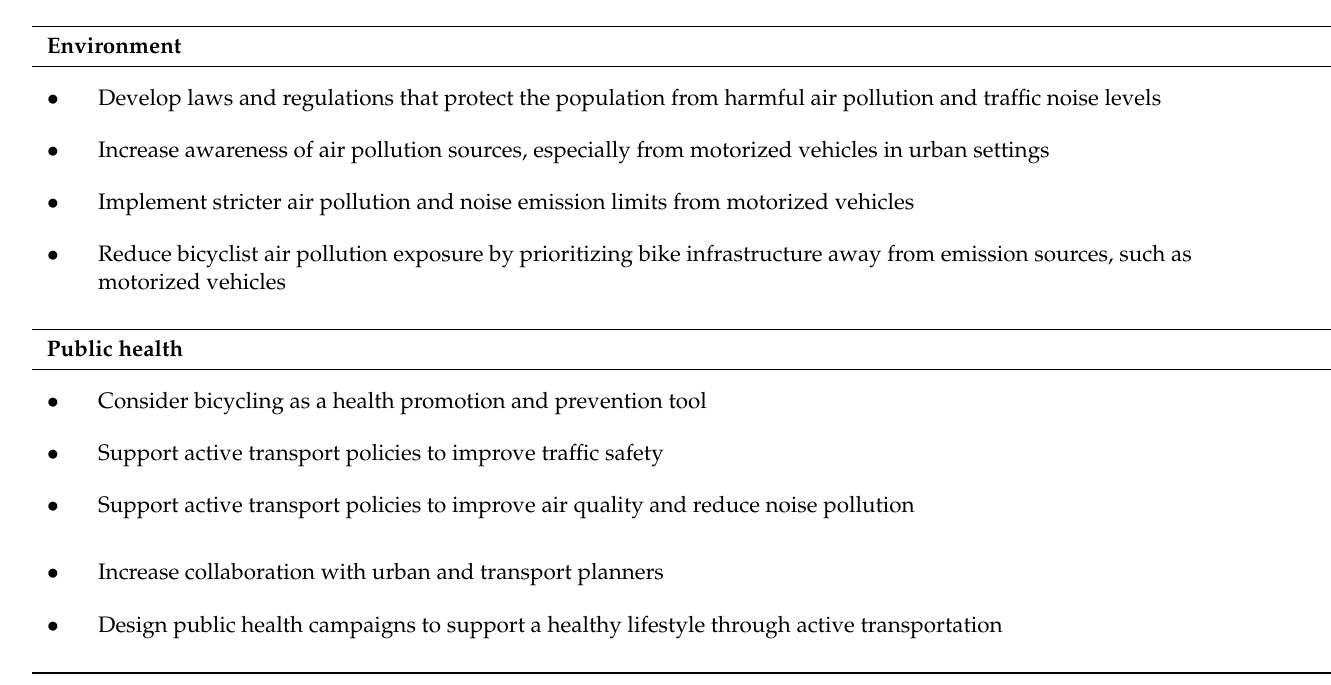
model; Table S1. Relative risk formulas for each model; Table S2. General formulas; Table S3. Air pollution variables; Table S4. Results in annual premature deaths in each scenario by risk factor; Table S5. Sensitivity results in premature deaths prevented each year in each scenario,